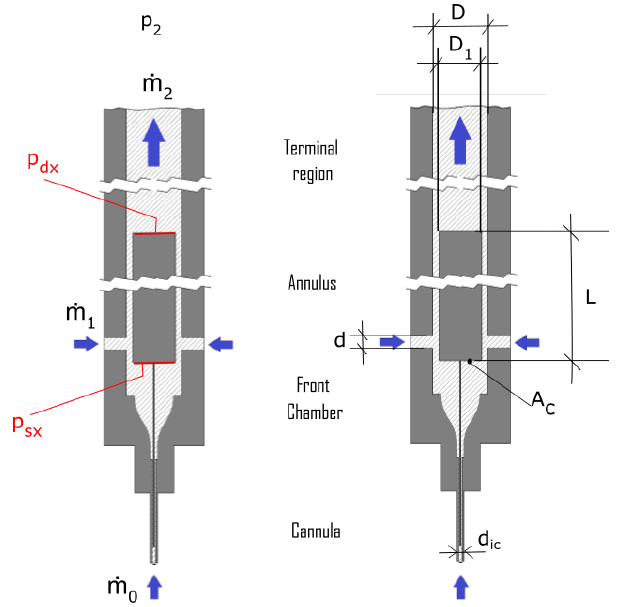
Figure 4. Nomenclature for the study of